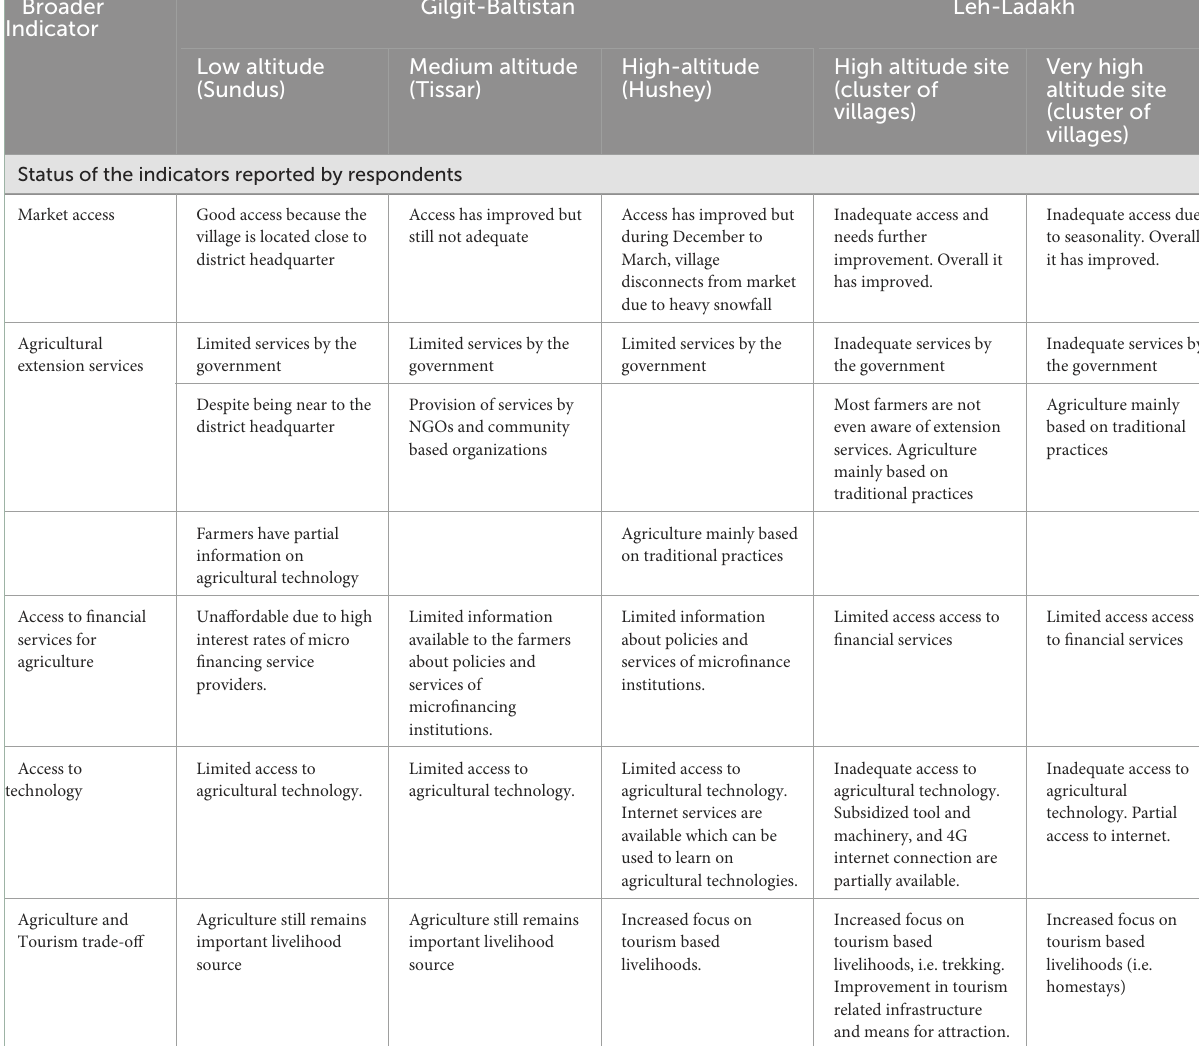
TABLE 6 Non-climatic challenges in agriculture. Broader